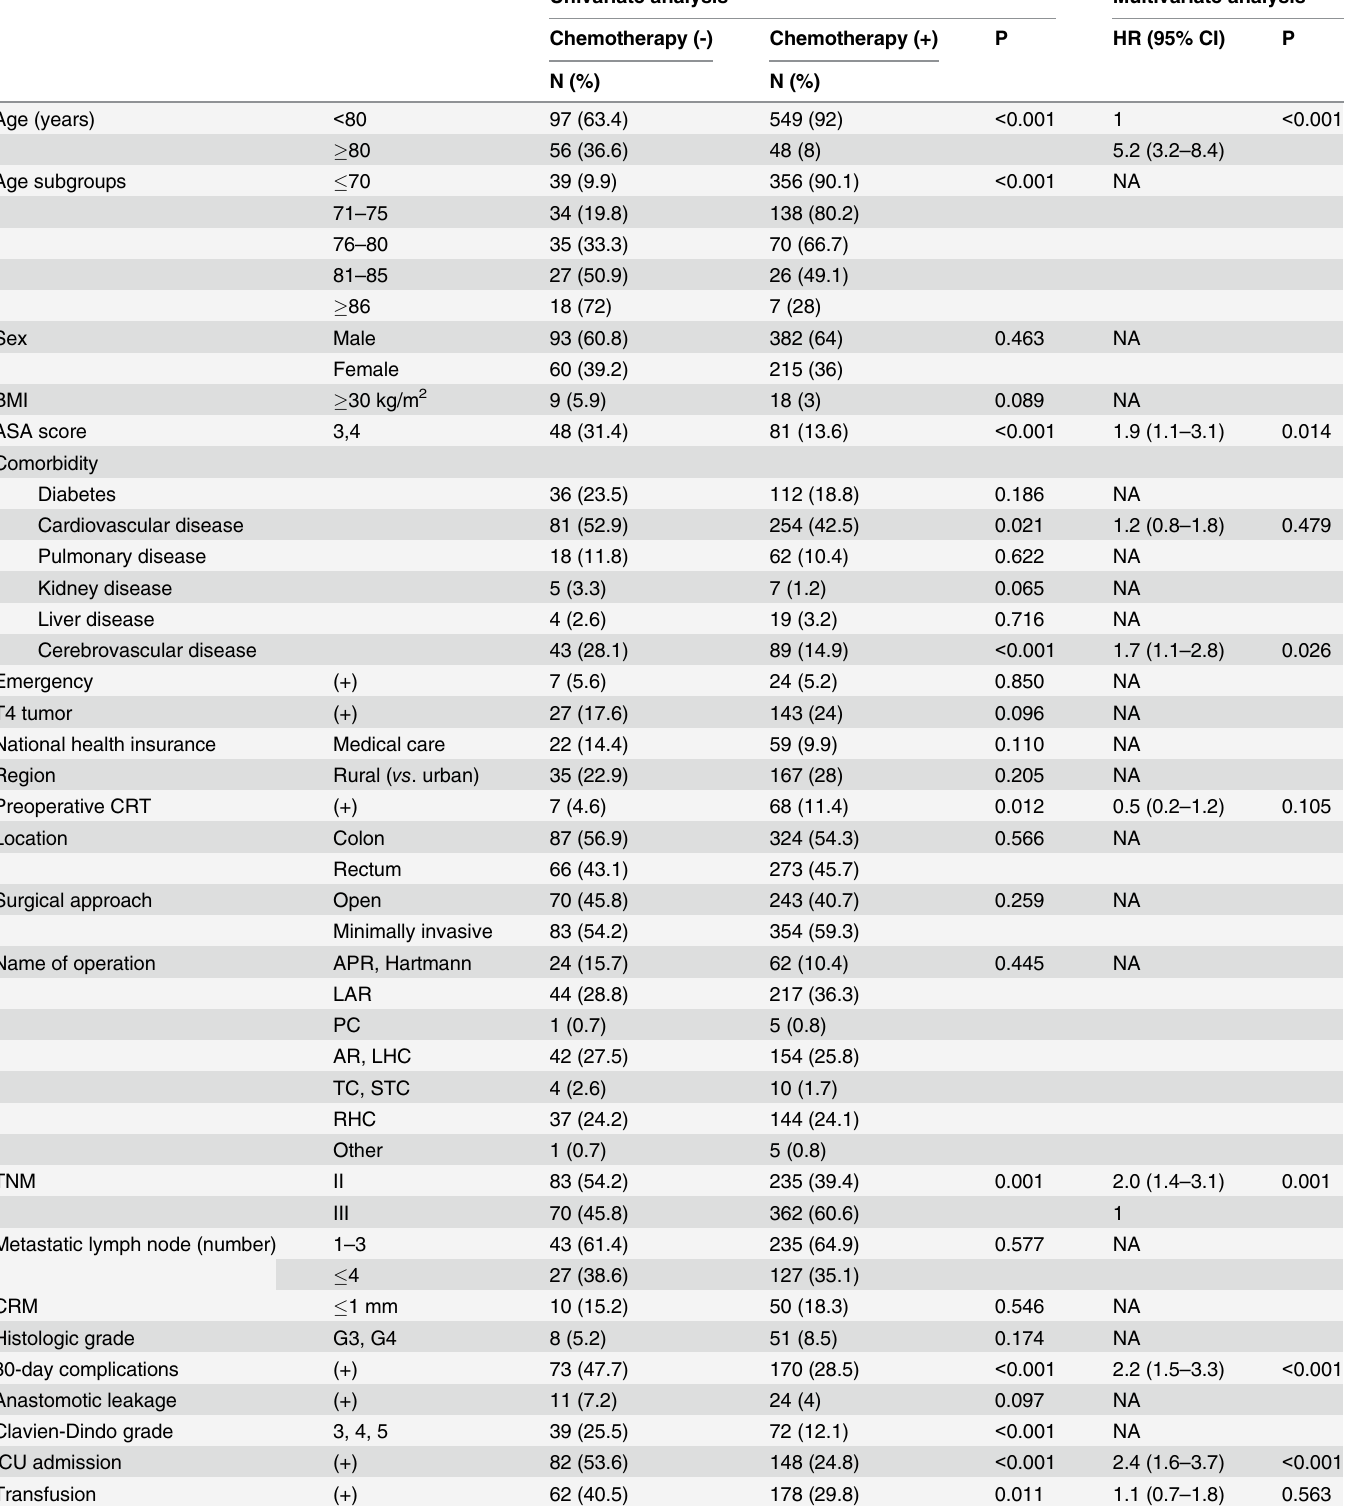
Table 2. Factors associated with not receiving adjuvant chemotherapy (n =